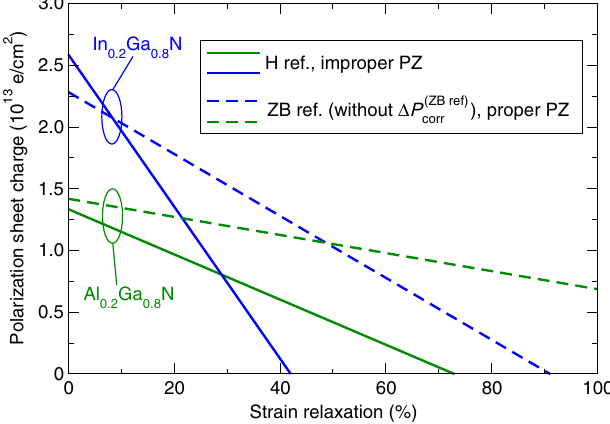
FIG. 3. Absolute values for polarization sheet charges at the In 0 Ga 0 N = GaN (blue) and Al 0 Ga 0 N = GaN (green) interface . 2 . 8 . 2 . 8 as a function of percent strain relaxation. Here, 0% relaxation corresponds to perfectly strained layers, and 100% relaxation to an unstrained overlayer at its bulk lattice constant. Solid curves are the correct implementation described in this work (H reference for SP and improper PZ constants); dashed curves are the current practice in the field (ZB reference for SP, without the correction term, and proper PZ